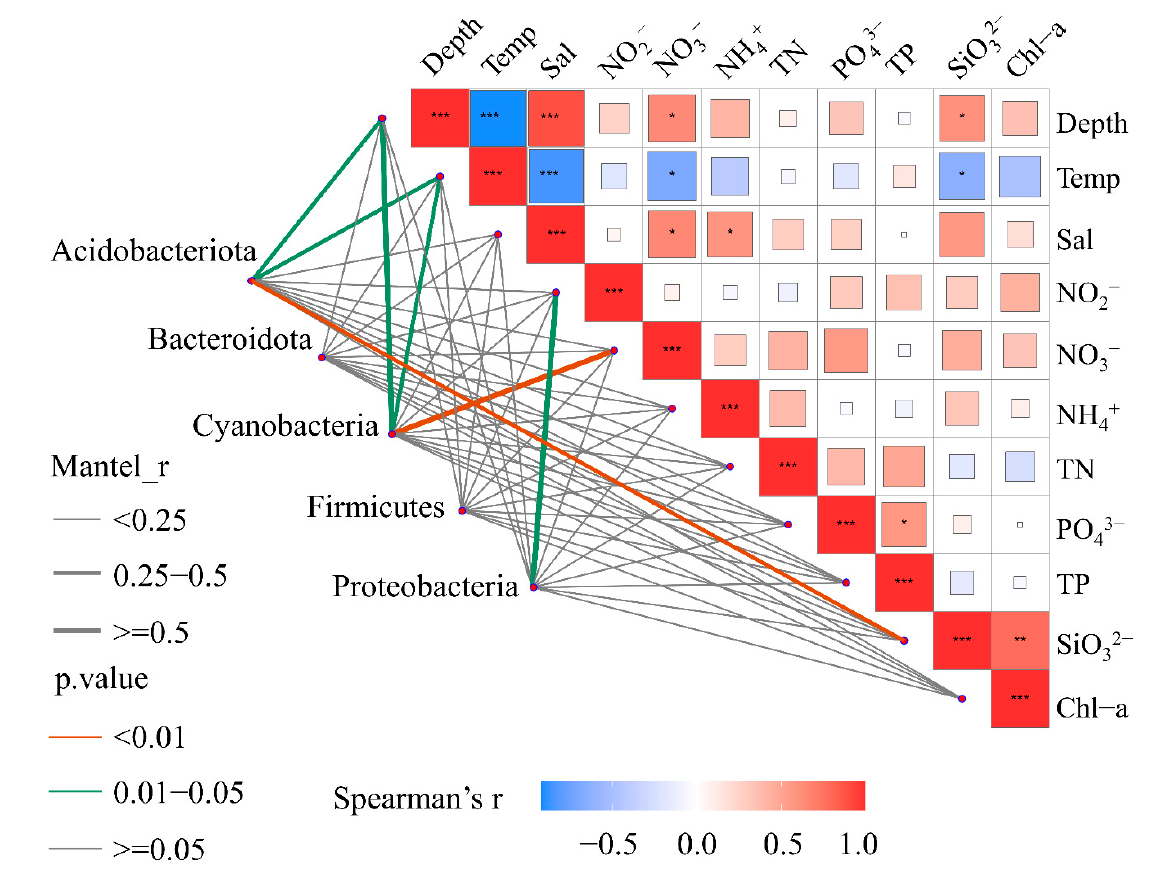
Figure 3. Correlations between bacterial community composition (phylum level) and biogeochemical parameters. The width of grey lines indicates the r-value of the Mantel test; the color of lines indicates the p-value. Asterisks indicate p < 0.05 and the color bar is based on the scale of Spearman’s correlation coefficient.